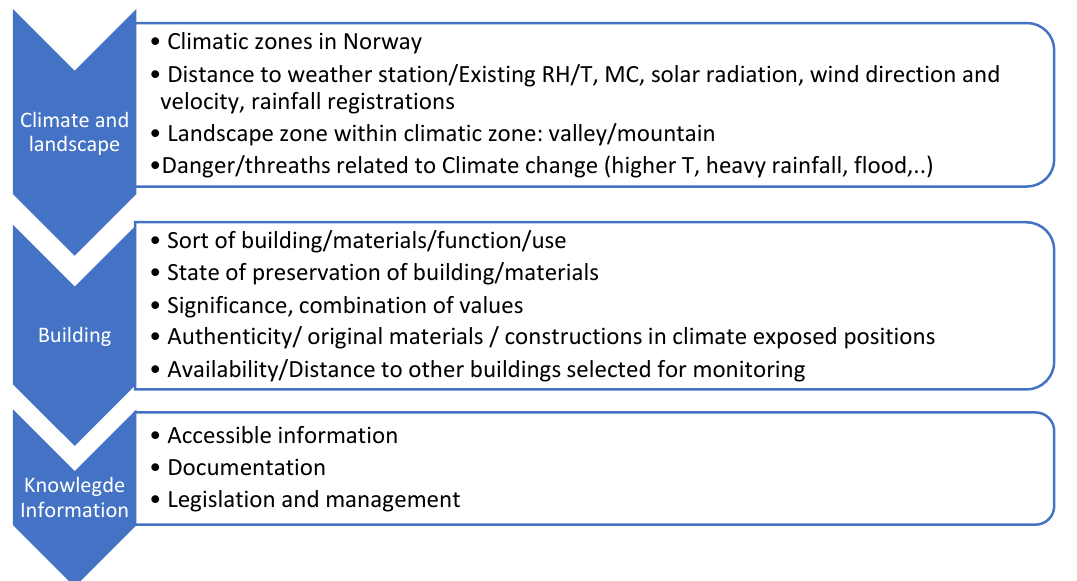
Figure 4. Criteria for the selection of buildings. RH = Relative Humidity, T = Temperature, and MC = Moisture Content.